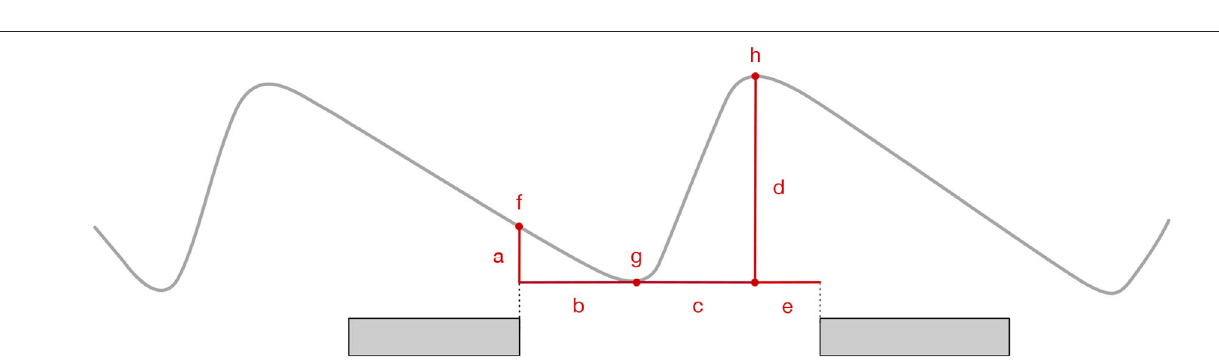
FIGURE 4 | Respiratory features: (a) exhalation amplitude, (b) exhalation duration, (c) inhalation duration, (d) inhalation amplitude, (e) speech lag, (f) exhalation onset level, (g) exhalation offset/inhalation onset level, (h) inhalation offset level. Exhaltory and inhalatory slopes were calculated as a/b and d/e, respectively. The gray bars represent